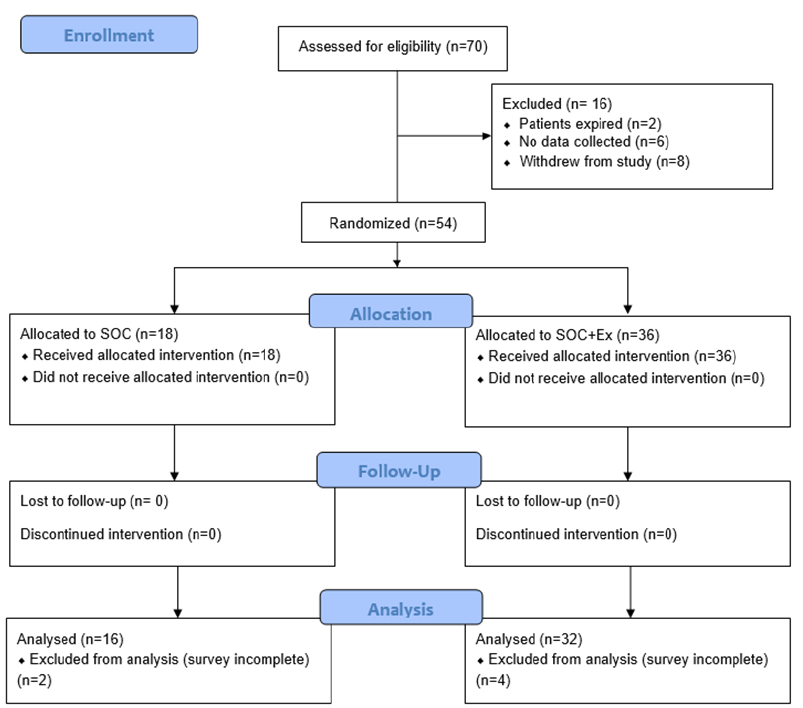
Figure 1. Flowchart illustrating study participant assessment for eligibility, randomization, enroll- ment, allocation to treatment group, follow-up, and analysis. SOC, standard of care; SOC+Ex, standard of care plus exercise.